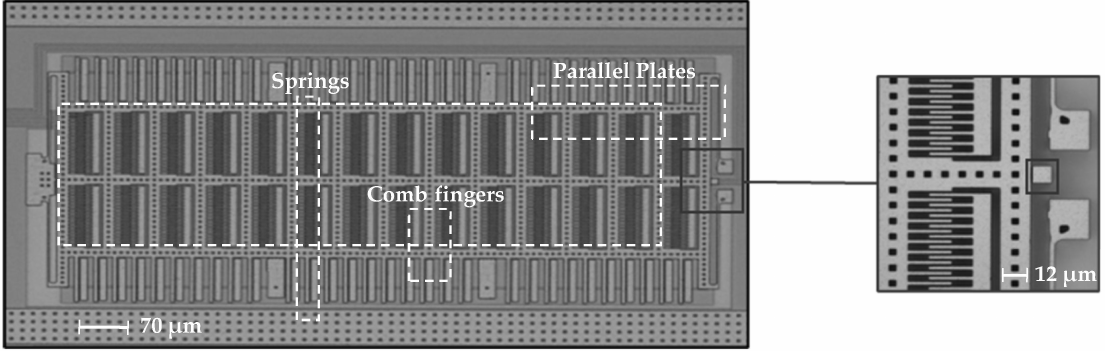
Figure 1. Micrograph of the device used in the experimental campaign; the inset on the right shows the stopper